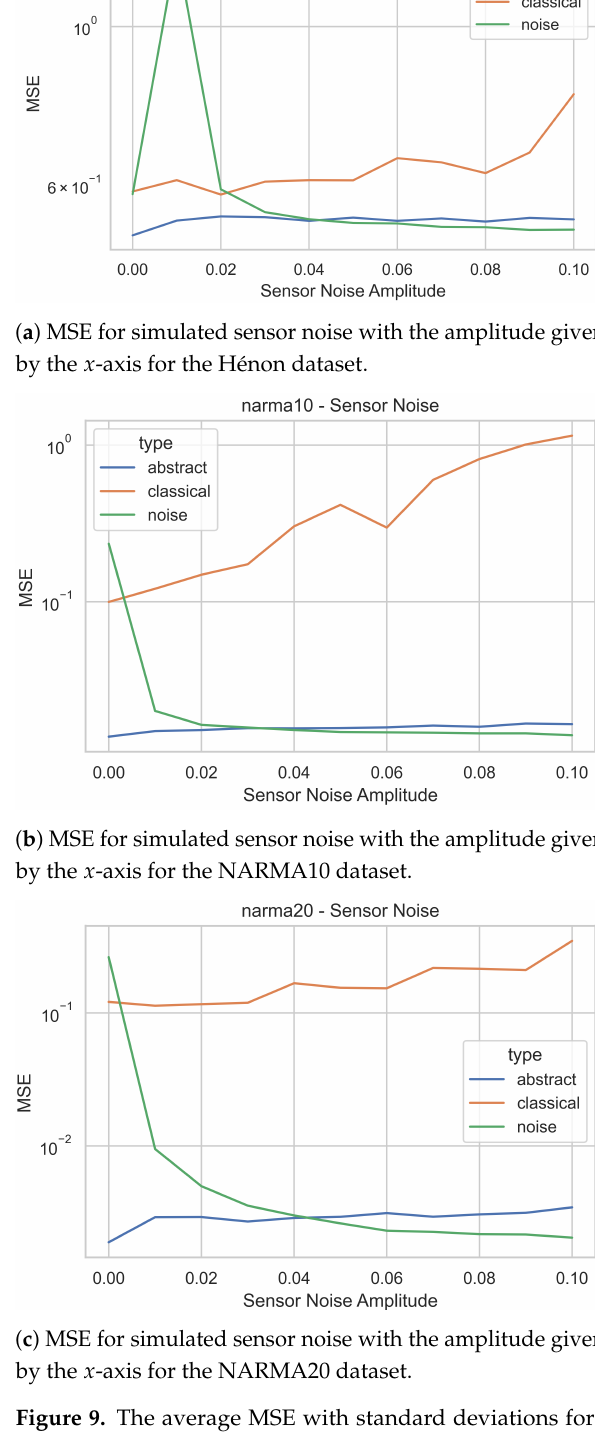
Figure 9. The average MSE with standard deviations for simulated sensor noise for the